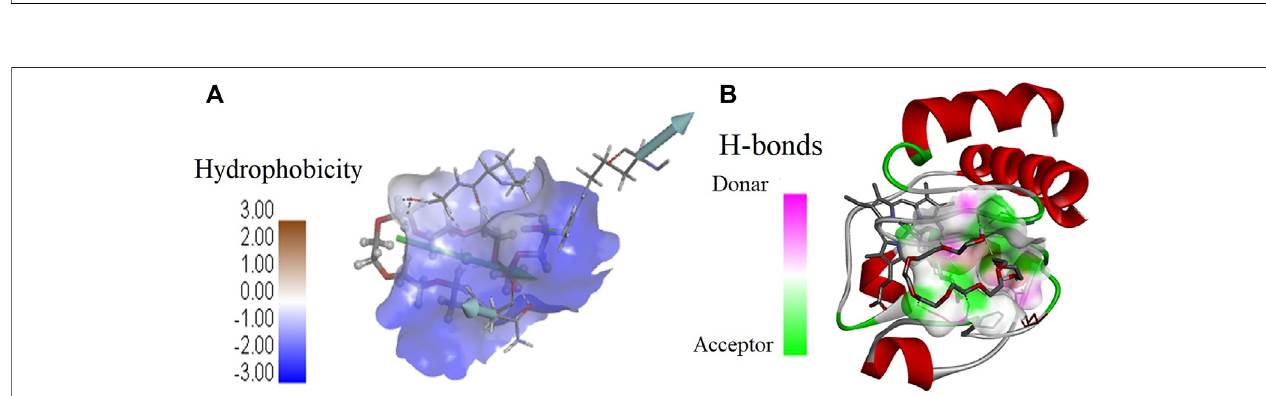
FIGURE 7 | Values of (A) hydrophobicity and (B) H-bonds (acceptor and donor) on the surface of cyt c interacting with PEG 10. (A) Porcupine plot shows hydrophobic moment outlines in the form of an arrow directing possible amphiphilic α -helical regions on the protein on interaction of PEG 10.